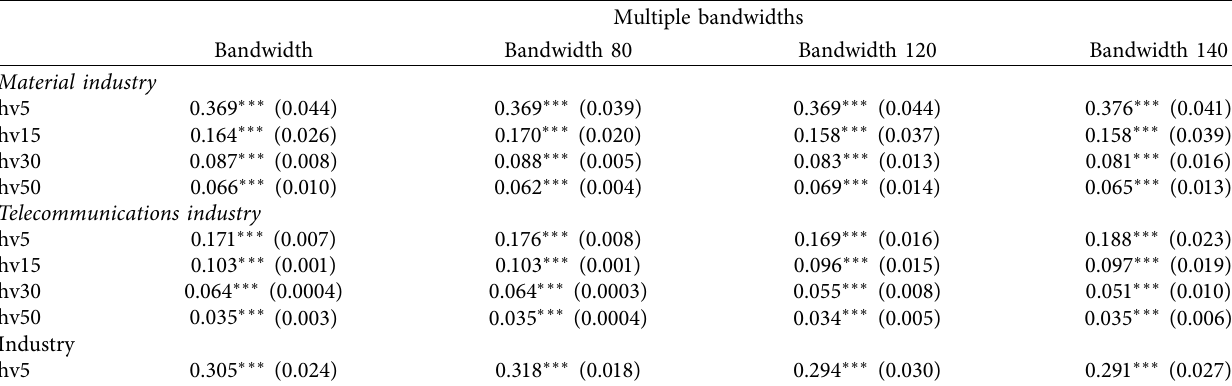
Table 4: RDD results for multiple